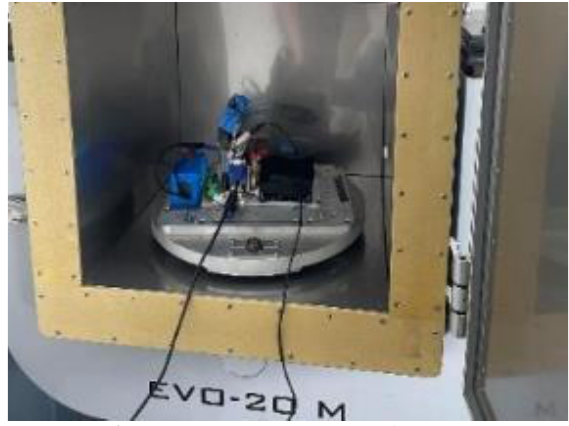
Figure 3 .Dynamic calibration of IMU500